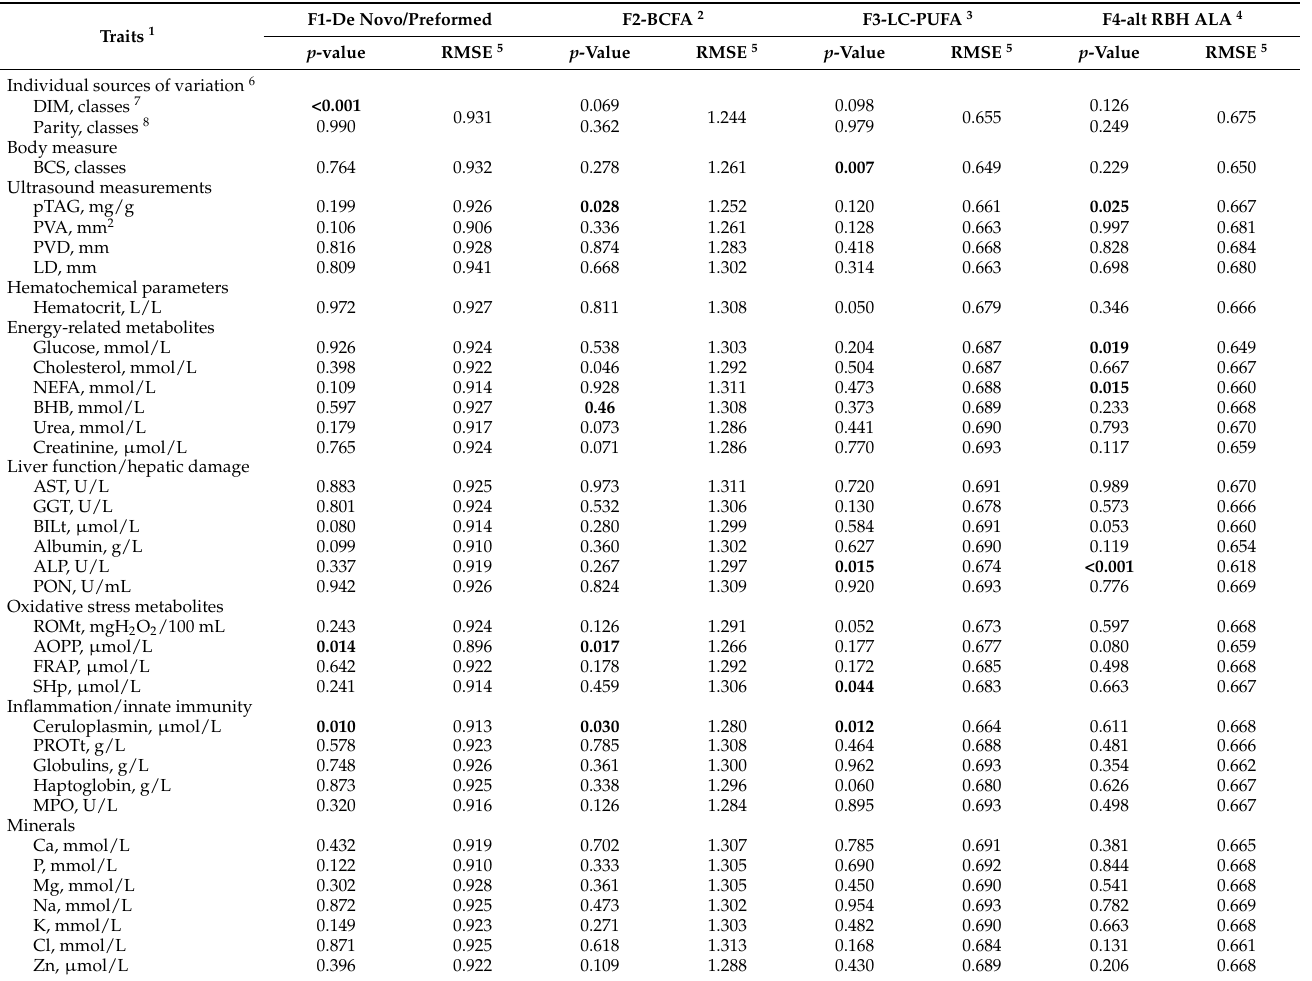
Table 3. Results from linear mixed model (p -values) for the extracted factors F1, F2, F3, and